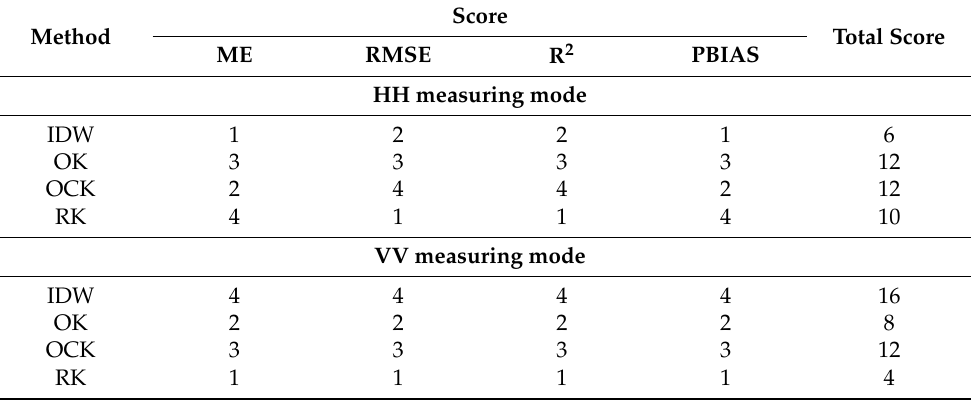
Table 17. The total score of four methods for identifying a suitable method for salinity prediction in the two measuring